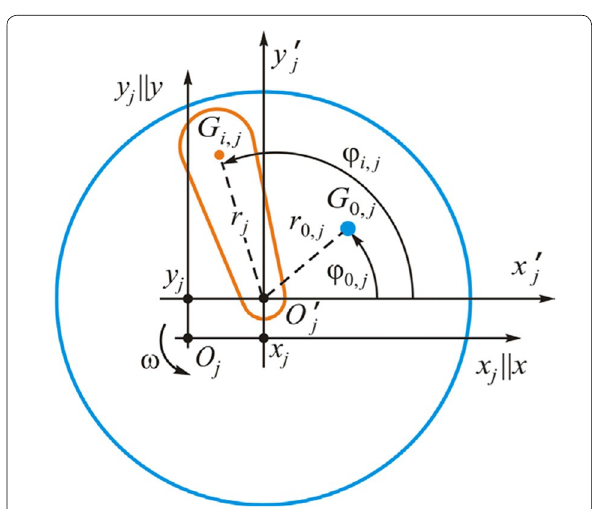
Figure 29 Dynamic model of pendulum balancing actuator Figure 30 Diagram of liquid-injection type balancing